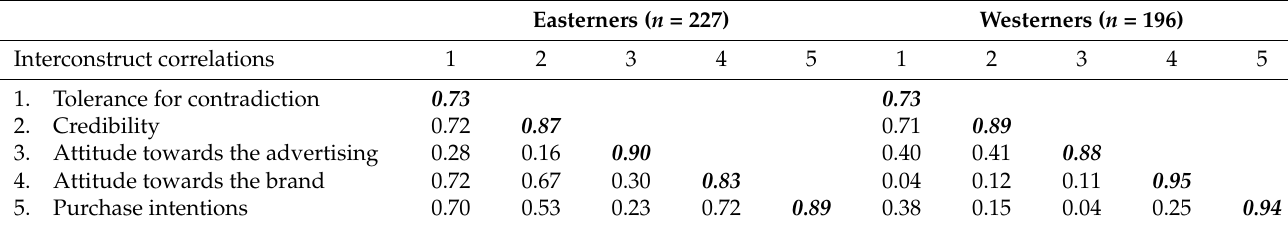
Table 4. Correlation